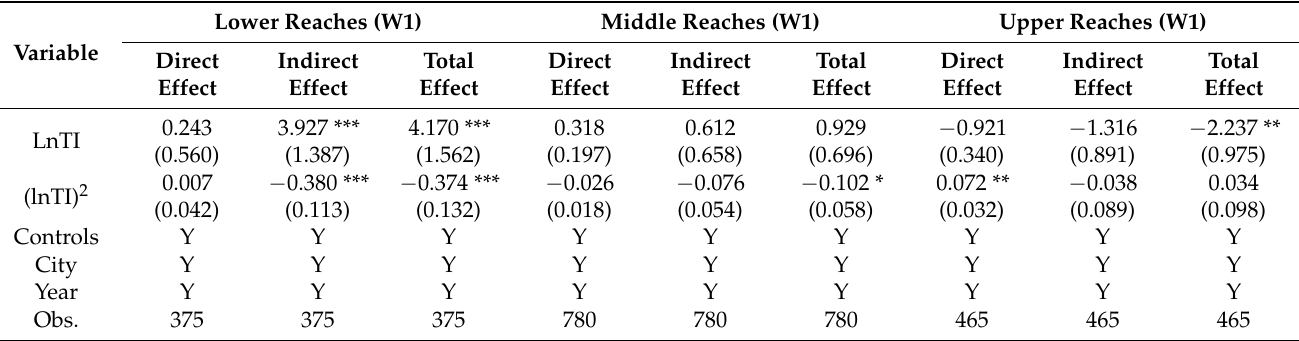
Table A1. The effect decomposition of SPDM.